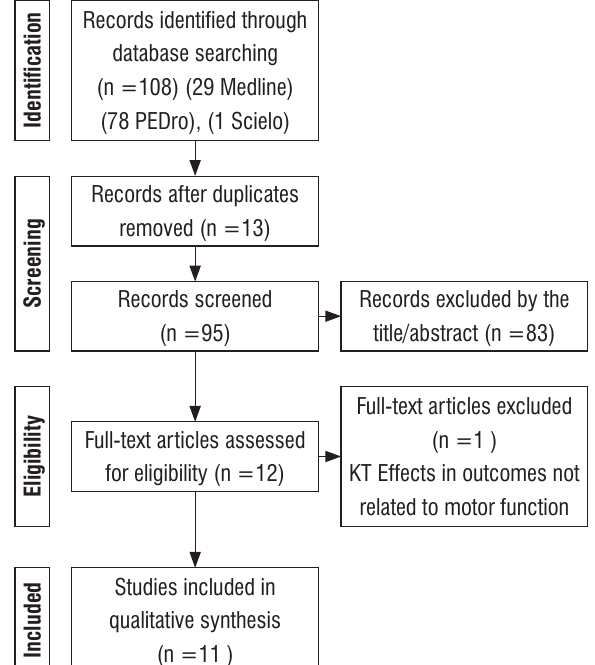
Figure 1 - PRISMA Flow